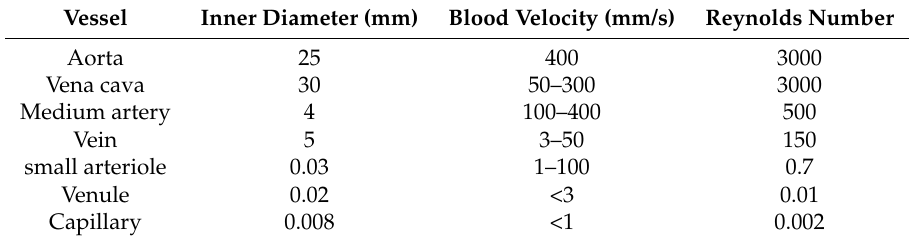
Table 1. Characteristics of different veins and arteries of the human circulatory system and the Reynolds numbers under the peak flow conditions [9,74]. Vessel Inner Diameter (mm) Blood Velocity (mm/s) Reynolds